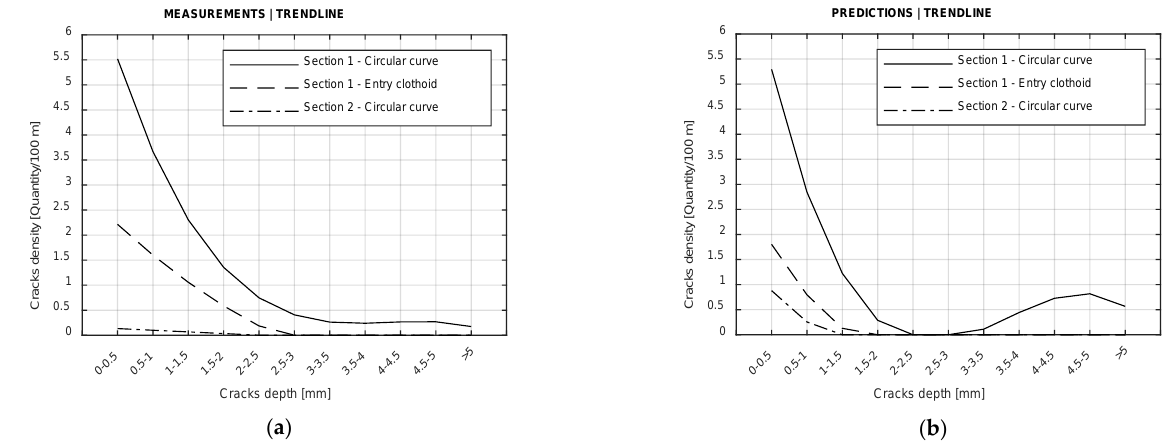
Figure 13. Comparison of the trend-lines between measurements and predictions for three different sections. Assessment with one measured cross-section per yard: ( a ) Measurements; ( b ) Predictions.